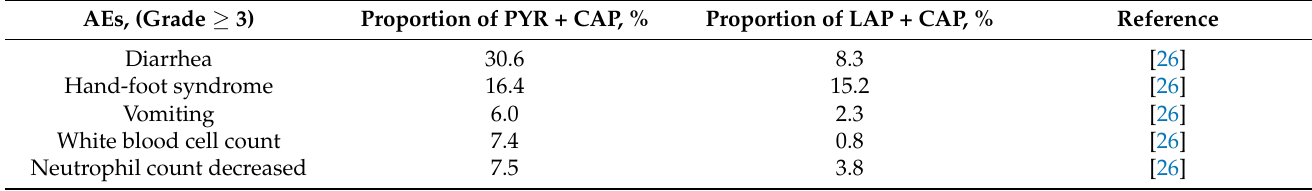
Table A1. Grade 3 or worse adverse events and its proportion between pyrotinib plus capecitabine and lapatinib plus capecitabine of patients with HER2-positive metastatic breast cancer.